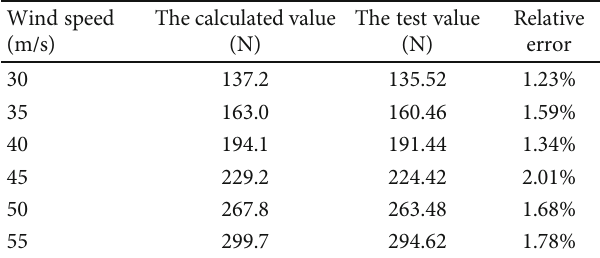
Figure 27: Test circuit board.